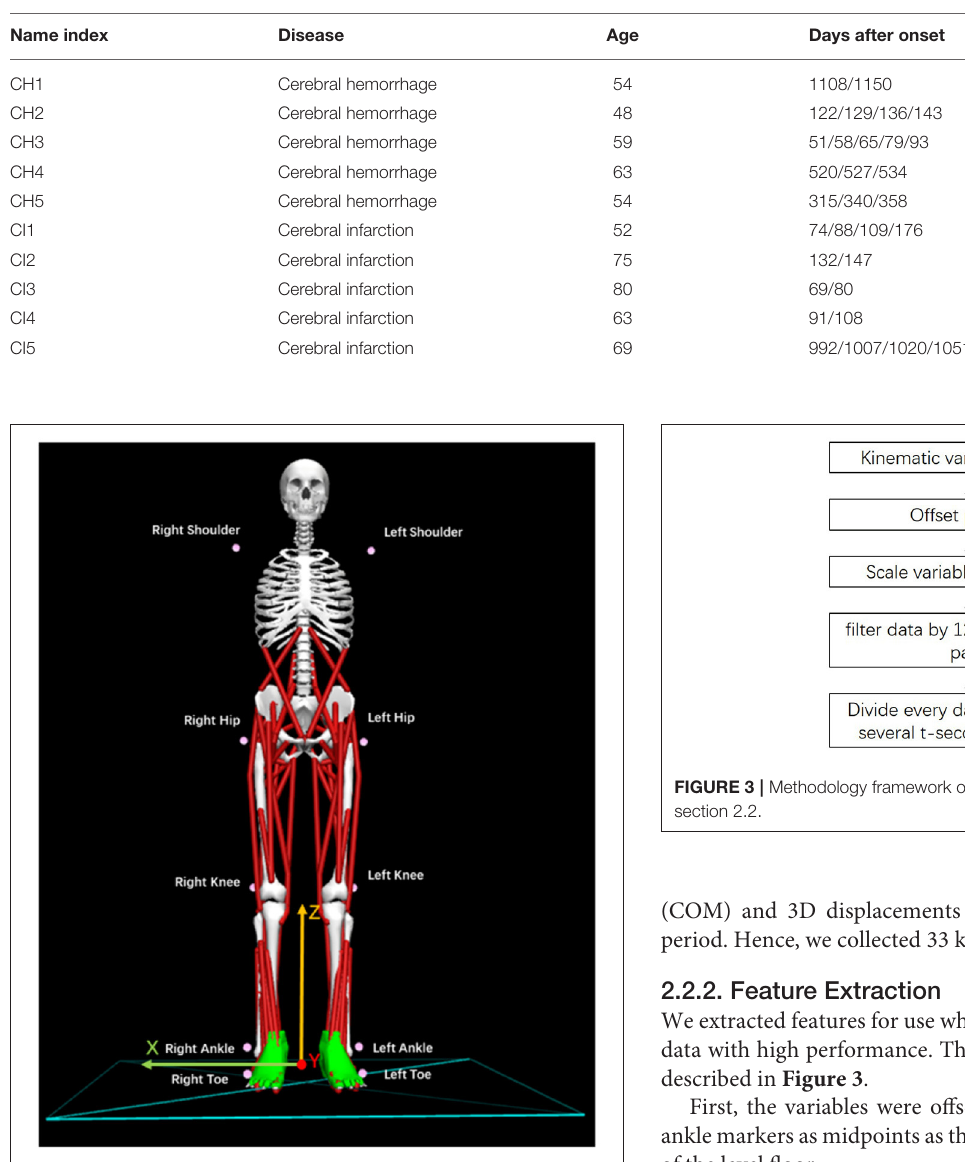
FIGURE 2 | Location and names of markers attached to the patients. Ten pink markers were attached to the body symmetrically.